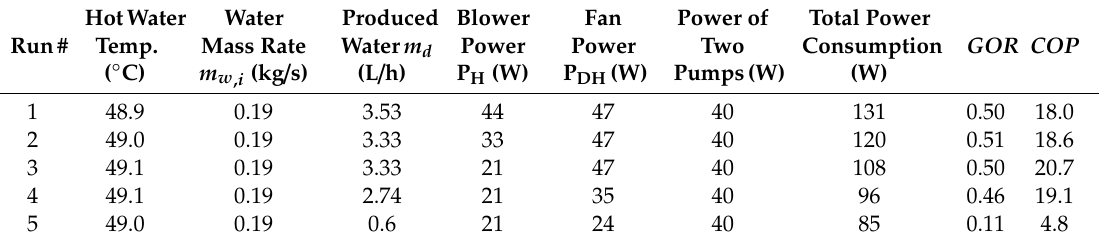
Figure 10. The coefficient of performance ( COP ) of the system versus the total power consumption of the system. The power consumption of the humidifier fan and de-humidifier fan is specified as a secondary axis. Pure water production is also shown as a reference. Table 3. Experiment data of some example runs with varying power consumption.